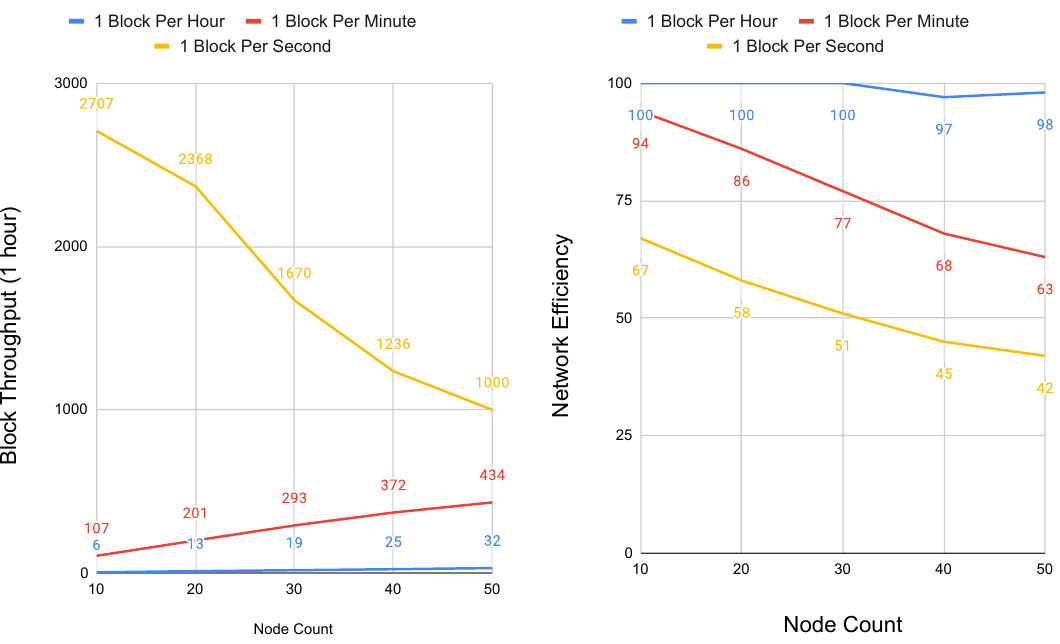
Figure 8. Performance and scalability of Conte at 1500 km node distances and maximum hops to graph edge of 50. Block Throughput ( left ) and Network Efficiency ( right ).